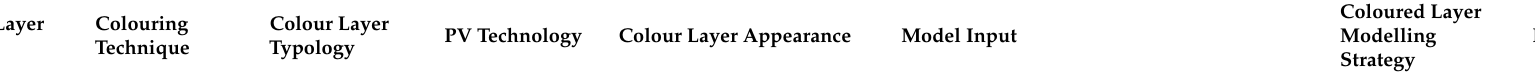
Table 2. Overview of the main characteristics of the analysed studies broken down by colour layer position, colouring technique, colour layer typology, PV technology (if applicable), and colour layer appearance. For each category, the main input and output of the proposed models have been reported, as well as the specific modelling strategy used for modelling the coloured layers and the reference of the